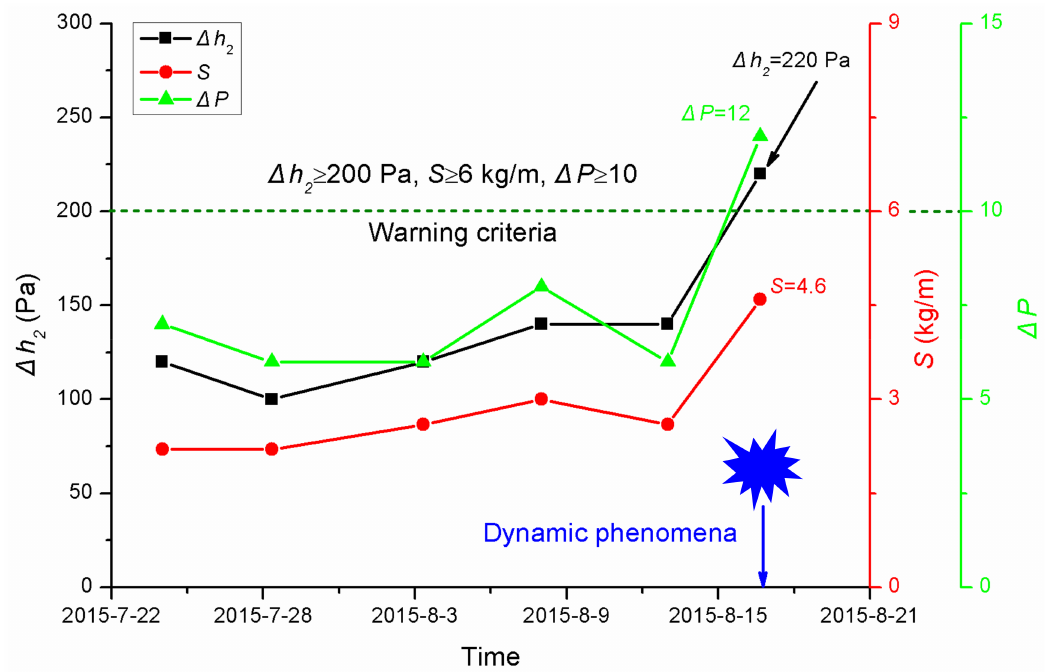
Figure 7. Conventional indicators before the dynamic phenomenon